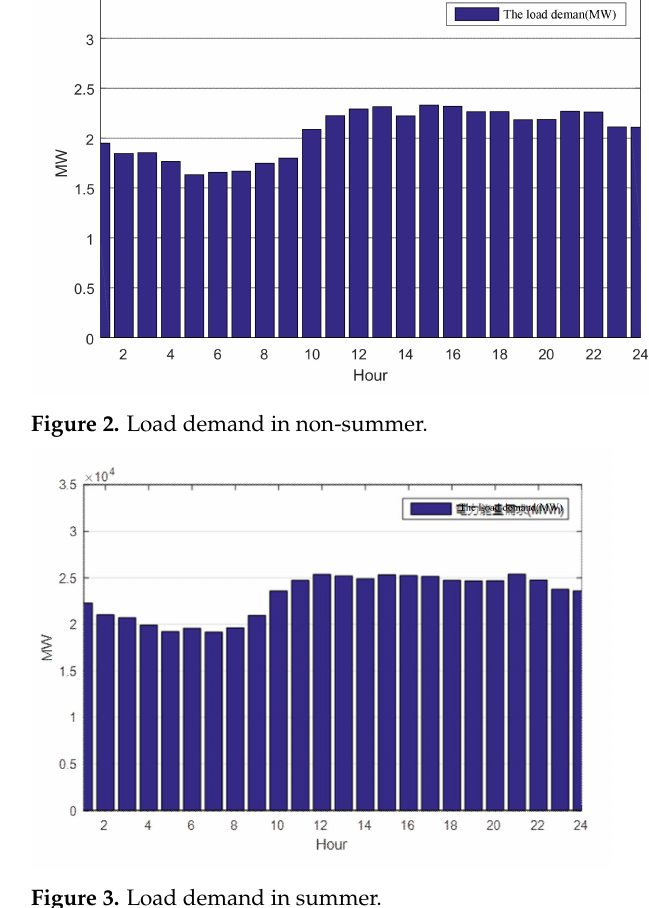
Figure 3. Load demand in